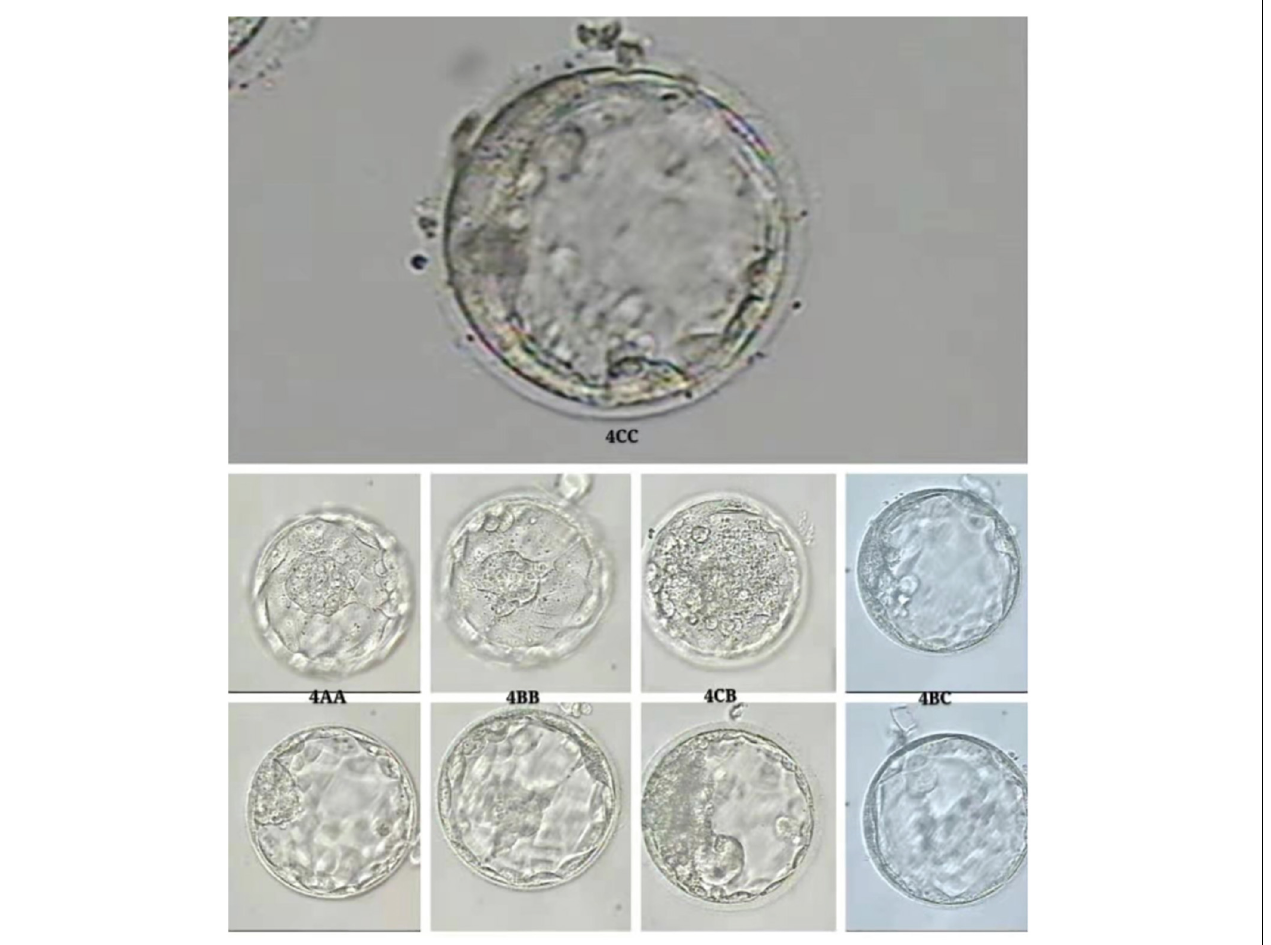
FIGURE 2 | The assessment of embryo viability using blastocyst scoring